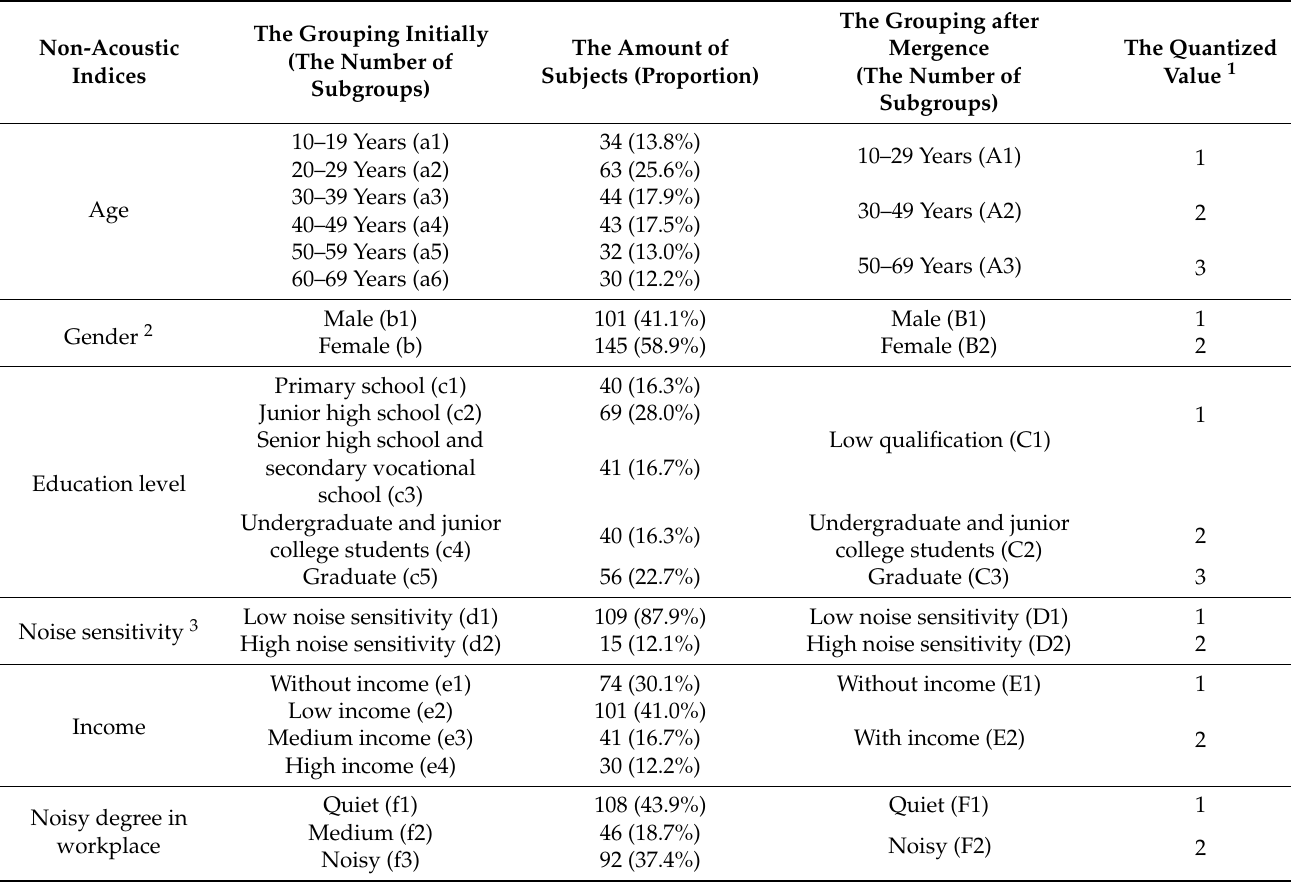
Table 1. Basic information and grouping of